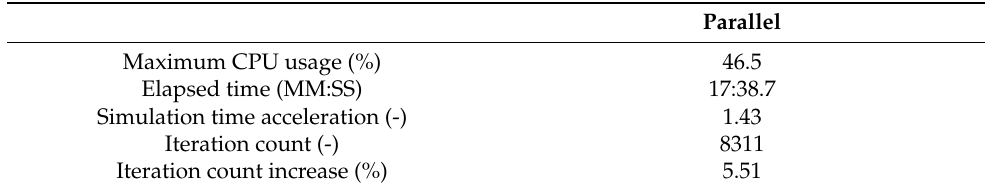
Table 2. Computational speed of the simulation with the Parallel method for a reduced number of mode shapes.